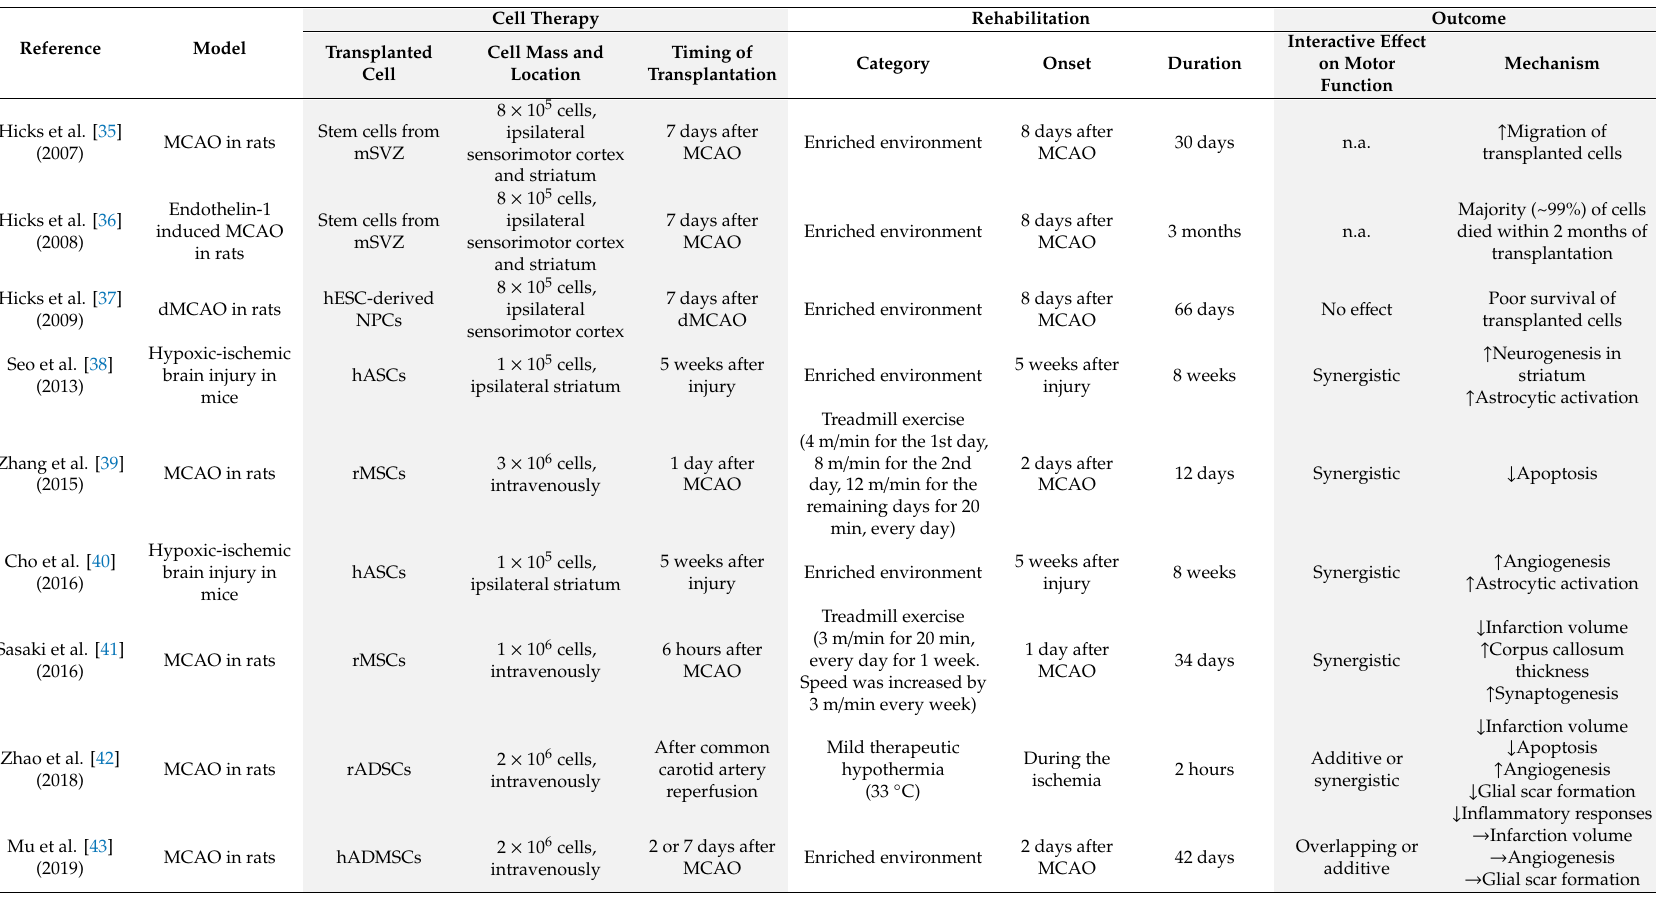
Table 1. Summary of therapeutic e ff ects of combining cell therapy and rehabilitation (excluding brain stimulation) on motor function in animal models of